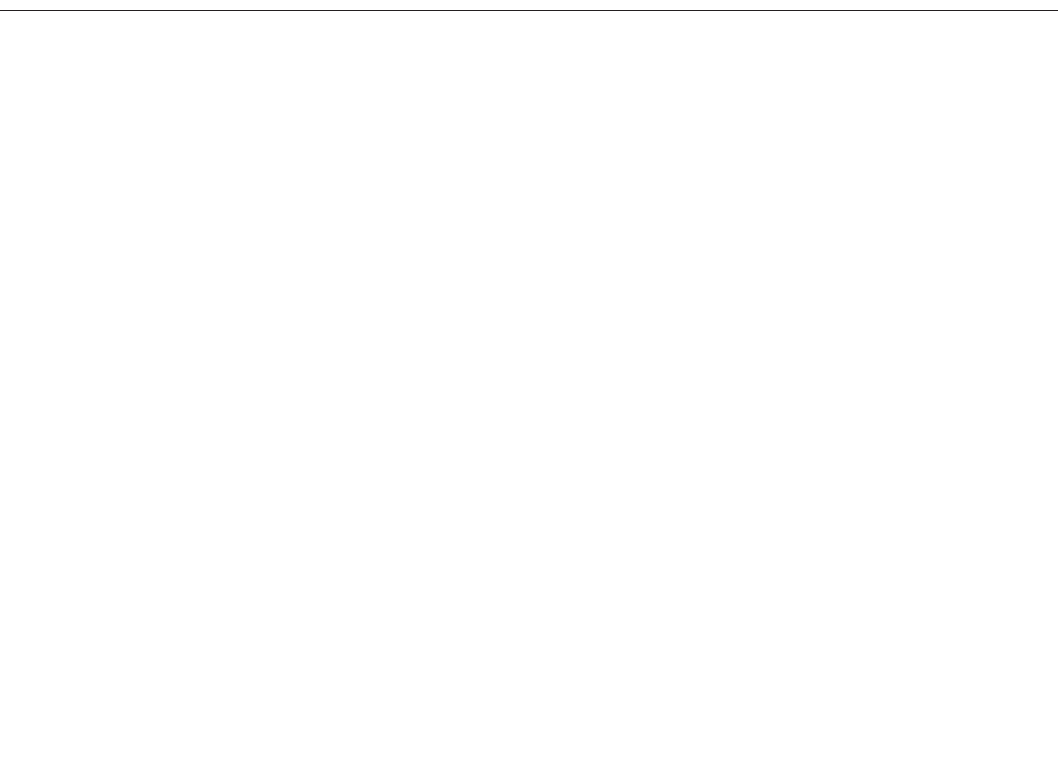
FIGURE A2 | Inverse solution of a simulation containing four source clusters. An exemplary, representative sample of inverse solutions for four source clusters. (A) The ERP at each of the 31 channels containing both signal (central peak) and realistic noise from real recordings. (B) The scalp map at the central ERP peak (vertical red line in A ). (C) The dipole moments plotted on the white matter surface of the template brain in lateral view of the left hemisphere. On the left , the ground truth source pattern is depicted with a source cluster in the motor cortex, supplementary motor area, insula and the middle temporal lobe of the left hemisphere. Various inverse solutions that aim to recover this pattern are depicted next to it. Voxels below 25% of the respective maximum are omitted for a clearer representation of the current